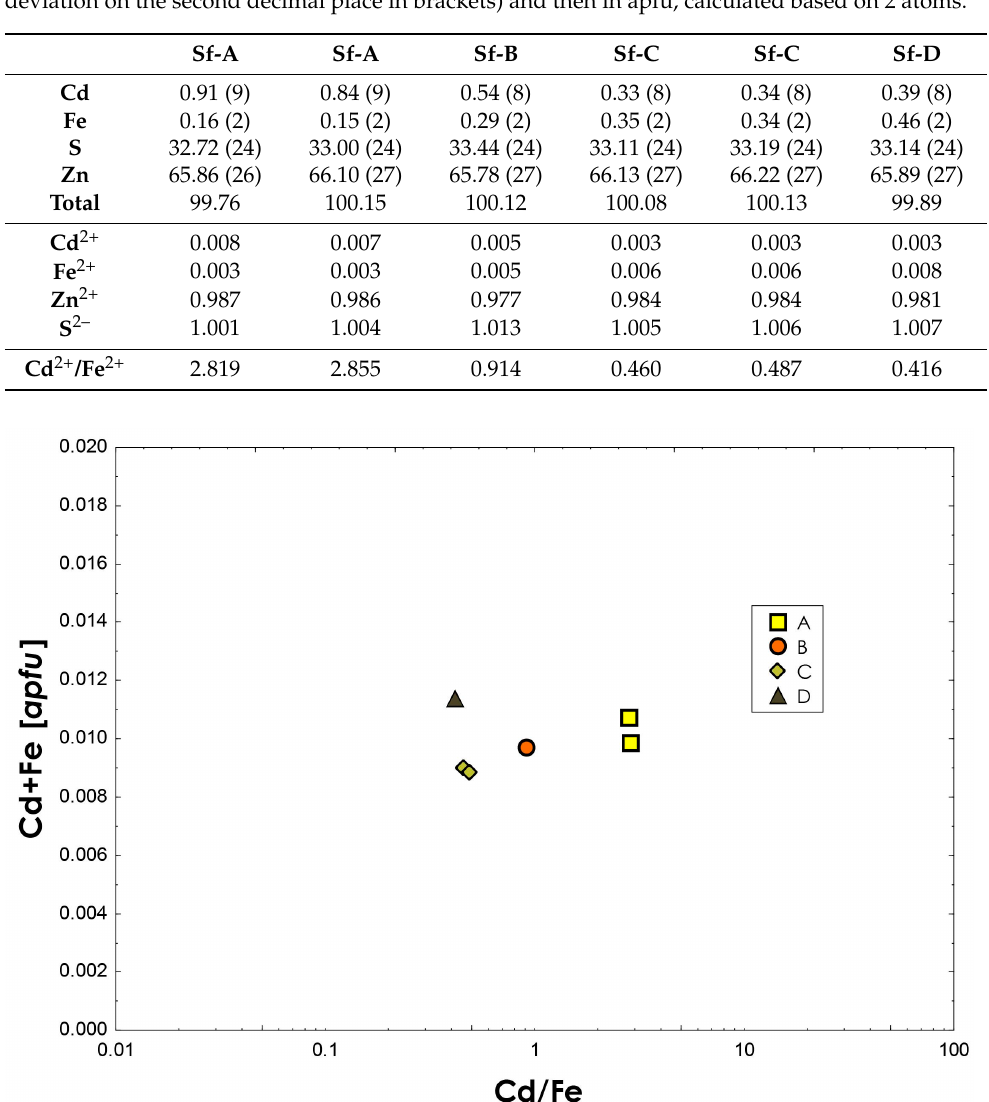
Table 1. Electron microprobe analyses of sphalerite samples, first presented in wt% (standard deviation on the second decimal place in brackets) and then in apfu , calculated based on 2 atoms.